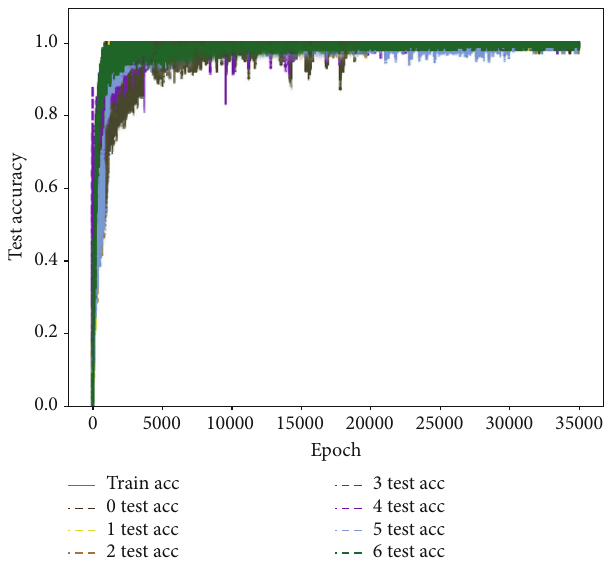
Figure 12: Accuracy rate curve of